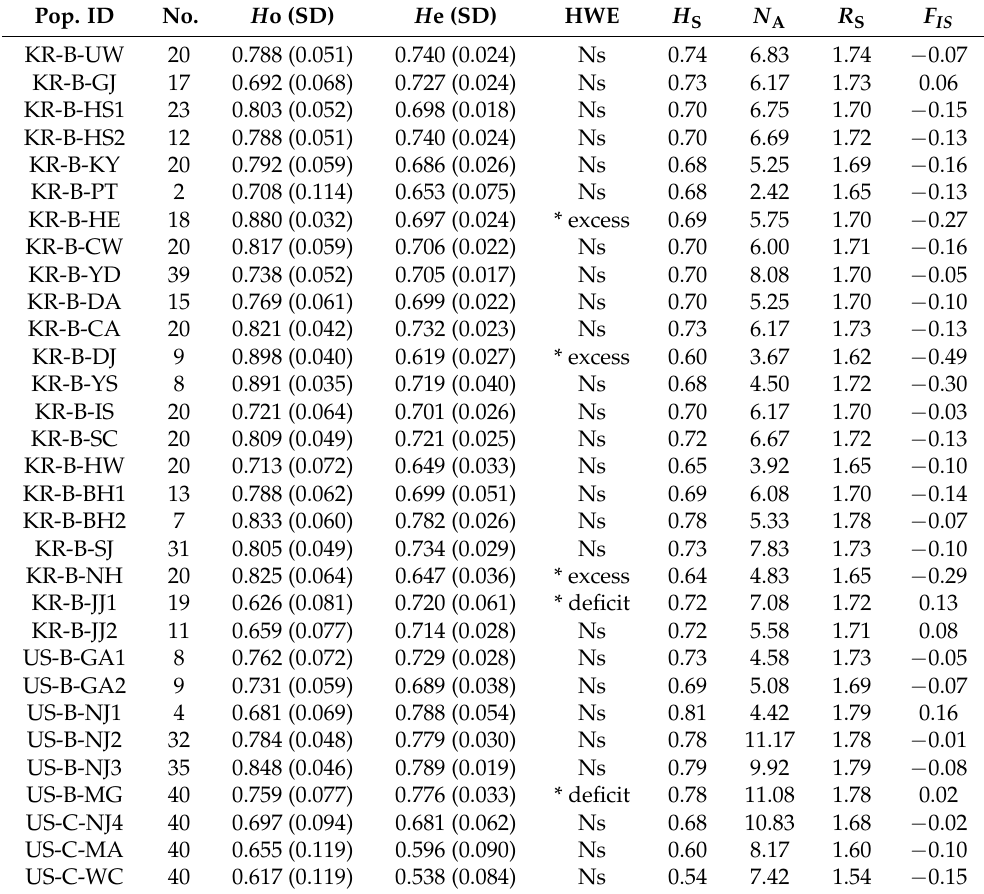
Table 1. Summary statistics for microsatellite data from Dasineura oxycoccana populations. Pop. ID